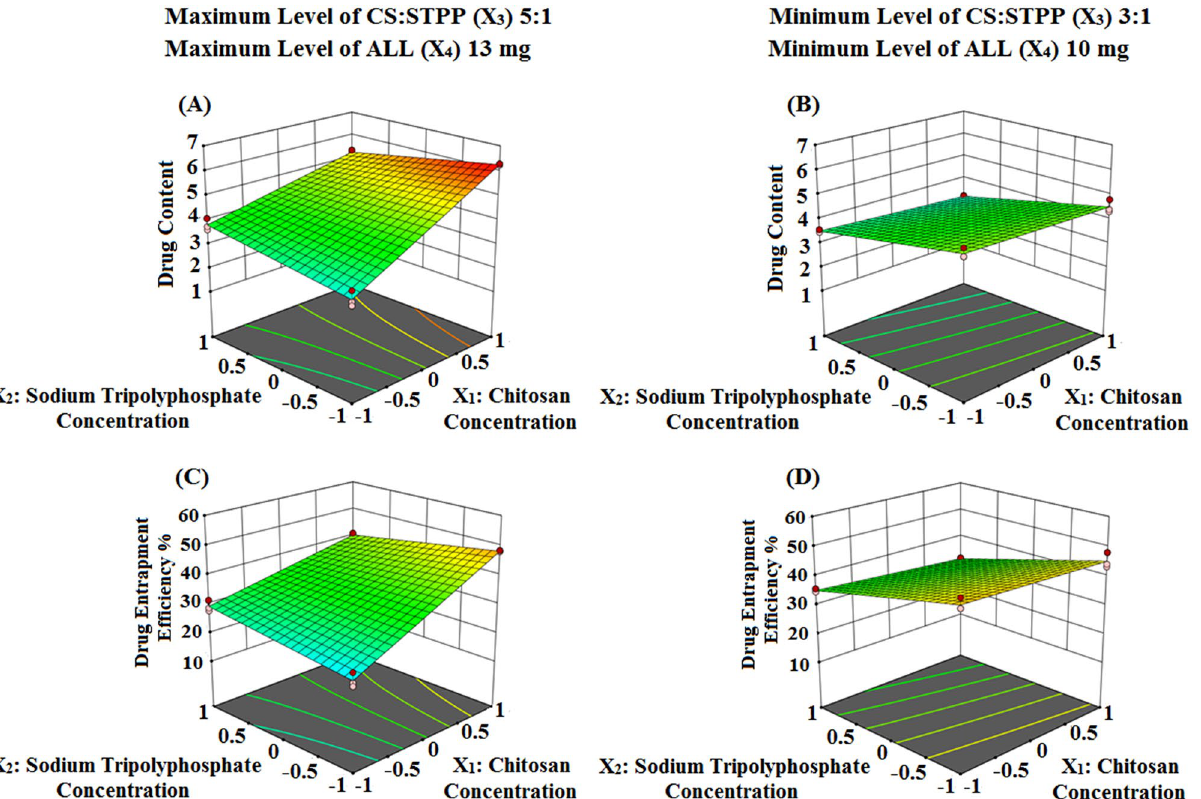
Figure 2. Three dimensional surface plots representing the effect of the interaction between the concentrations of both CS (X 1 ) and STPP (X 2 ) on Q and DEE % ( A and B ) and ( C and D ) at the maximum and minimum levels of both CS:STPP volume ratio (X 3 ) and ALL amount (X 4 ), respectively, using Design-Expert version 12 (/https :// www.state ase.com/softw are/desig n-exper